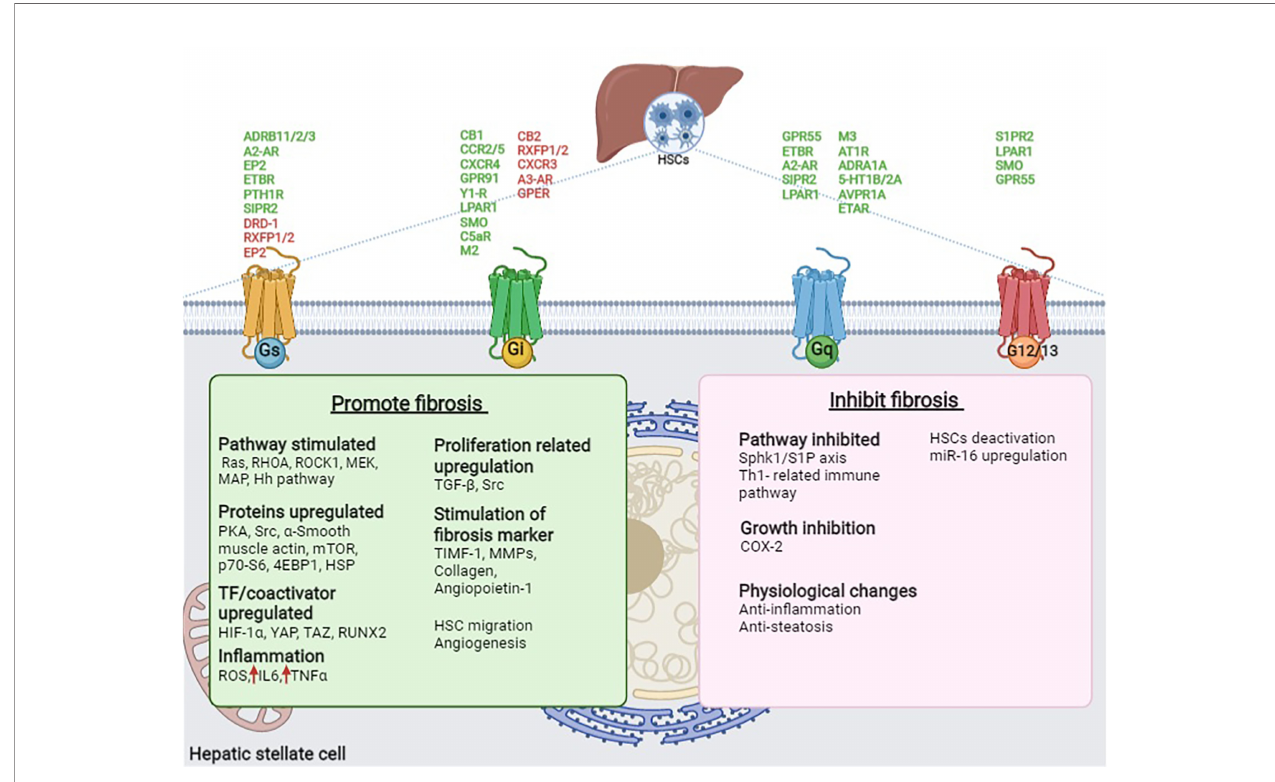
FIGURE 3 | GPCRs present in HSCs involved in promoting and inhibiting fi brosis in the liver. GPCR (Green- promote fi brosis and Red- inhibits fi brosis), Ach, Acetylcholine; ADRB1/2/3, b 1/2/3-adrenoceptor; AVPR1A, Arginine vasopressin receptor 1A; AT1R, Angiotensin II type I receptor; A2-AR, Adenosine A2A receptor; CB1/2, Cannabinoid receptor 1/2; CCR2/5, C-C chemokine receptor type 2/5; COX2, Cyclooxygenase 2; CXCR3/4, C-X-C motif chemokine receptor 3/4; C5aR, C5a receptor; C5a, Complement peptide; DRD1, Dopamine receptor D1; EP2, Prostaglandin E receptor 2; EPI, Epinephrine; ETAR/BR, Endothelin receptor type A/B; ETBR, Endothelin receptor type A; Fz2, Frizzled receptor 2; GPR91, G protein-coupled bile acid receptor 91; GPR55, G protein-coupled receptor 55; GPER, G protein-coupled estrogen receptor 1; Hh, Hedgehog; HIF-1 a , Hypoxia-inducible factor 1- a ; HSC, Hepatic stellate cell; HSP, Heat shock proteins; IL6, Interleukin-6; LA, Lysophosphatidic acid; LPAR1, Lysophosphatidic acid receptor 1; MAPK, mitogen-activated protein kinases; miR-16, microRNA 16; MEK, Mitogen-activated protein kinase; MMP, Matrix metalloproteinases; mTOR, mammalian target of rapamycin; M2/3, M2/3 acetylcholine receptor; NE, Norepinephrine; NPY, Neuropeptide Y; PKA, Protein kinase A; PGE2, Prostaglandin E2; PTHLH, Parathyroid Hormone Like Hormone; PTH1R, Parathyroid hormone 1 receptor; RHOA, Ras homolog family member A; RLN, Relaxin; ROCK, Rho-associated protein kinase; ROS, reactive oxygen species; RUNX2, Runt-related transcription factor 2; RXFP1/2, Relaxin family peptide receptor 1/2; SMO, Smoothened receptor; S1PR2, Sphingosine-1-phosphate receptor 2; TAZ, PDZ-binding motif; TGF- b . Transforming growth factor- beta; TIMF-1, Thymocyte Interaction Modulation Factor; 5-HT1B/2A, Serotonin receptor 1B/2A; p70-S6, S6 kinase beta-1; 4EBP1, 4E binding protein; Sphk1/S1P, sphingosine kinase-1/sphingosine-1-phosphate; YAP, yes-associated protein 1; Y1-R, Neuropeptide Y receptor